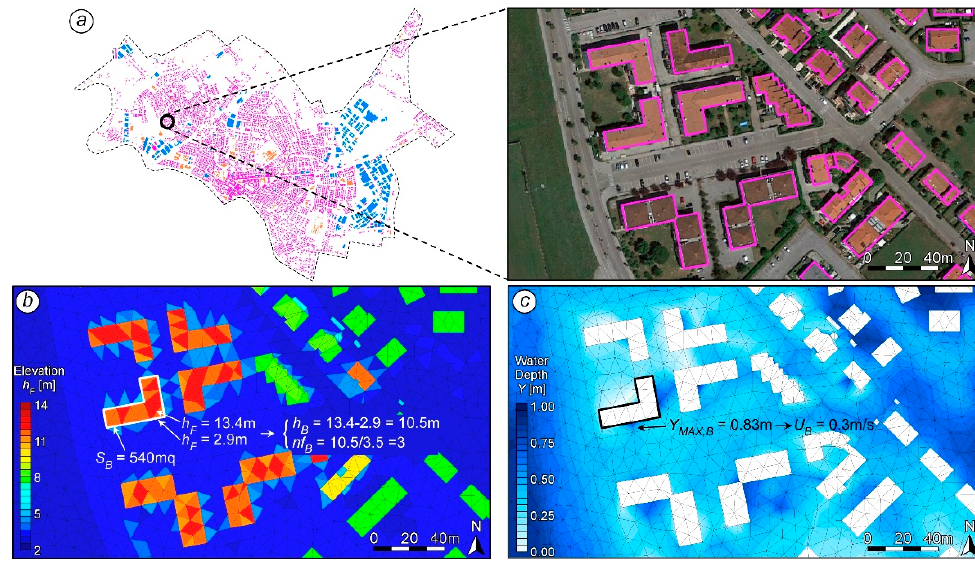
Figure 4. Method to compute flood damage. ( a ) Study area with a zoomed-in view of building footprint superimposed on the aerial image; ( b ) computational grid with details of the estimation of the surface S B and the number of floors nf B of buildings; ( c ) plot of instantaneous water depths with details of the estimation of the hydrodynamic forcing on a single building. (i.e., maximum surrounding water depth Y MAX,B and velocity U B